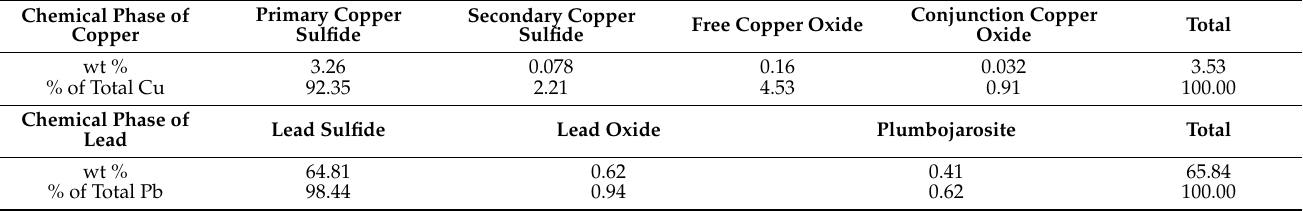
Table 2. Chemical phase of copper and lead in the copper–lead bulk concentrate (wt